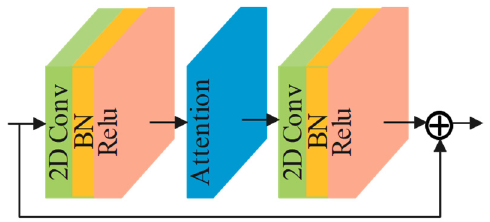
Figure 6. Residual attention blocks.